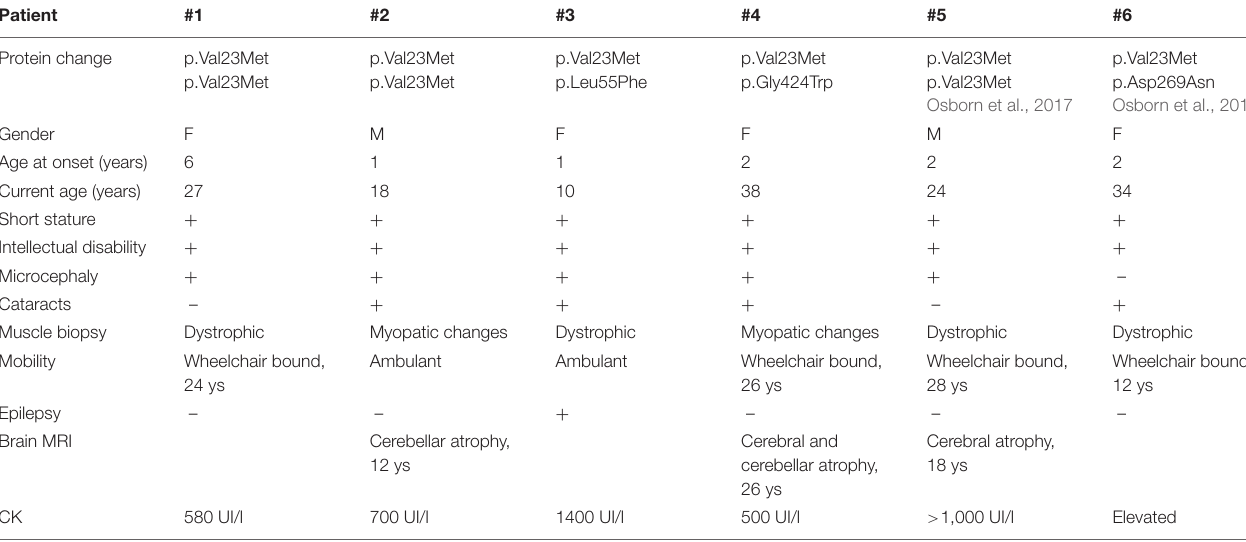
TABLE 1 | Clinical features of patients with INPP5K V 23 M